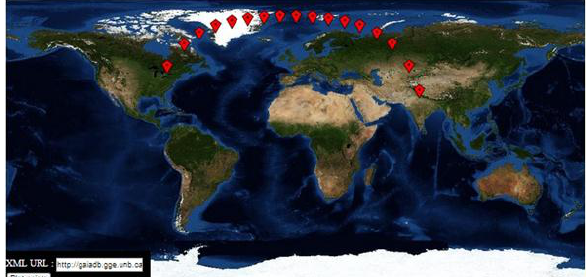
Figure 11. Example visualization of an XML file content (shortest